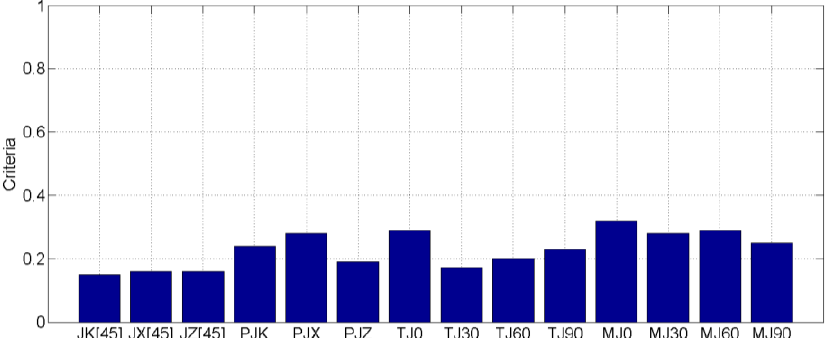
Figure 6. A bar chart showing the maximum criteria for 14 substructures using local buckling strength analysis under the extreme condition with comprehensive (3D) loads.